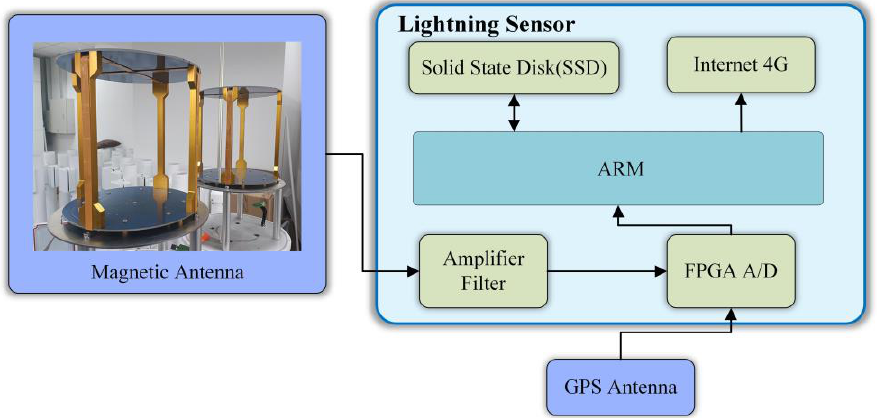
Figure 3. Block diagram of lightning sensor equipment components.